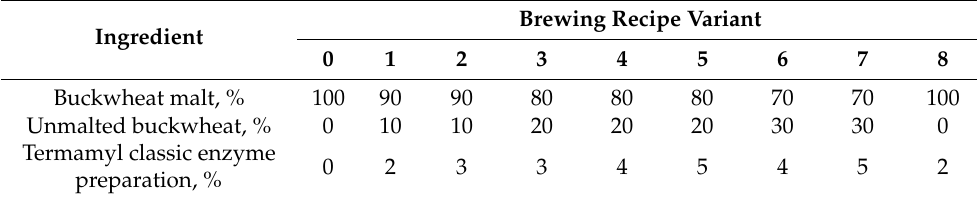
Table 1. Variant mashing recipes used in experiments.